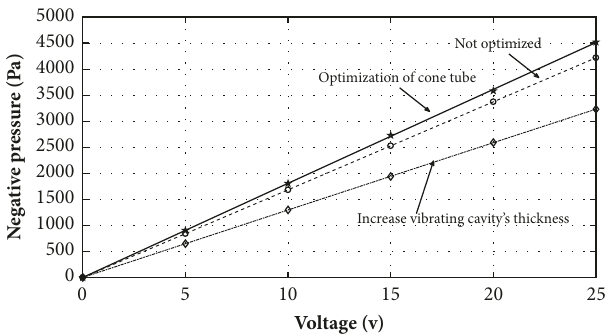
Figure 19: Relationship between the negative pressure and the driving voltage’s amplitude.